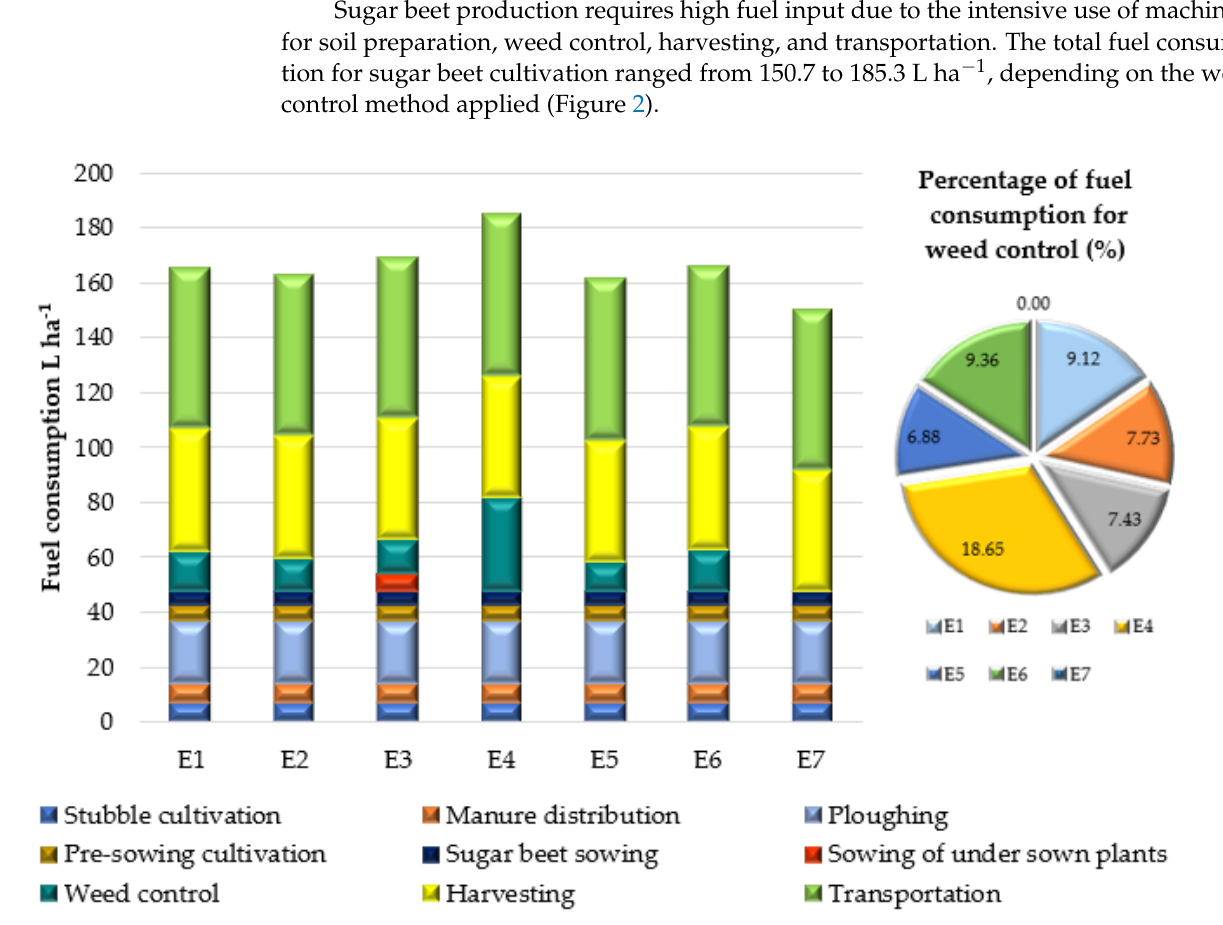
Figure 2. Total fuel consumption of organic sugar beet production using different weed control methods. E1—mechanical weed control (inter-row loosening), E2—mechanical weed control (inter-row cutting and mulching with weeds), E3— smothering weed control (inter-row cutting and mulching with catch crop), E4—thermal weed control (steaming), E5—inter- row loosening (automated), E6—inter-row loosening (robot—diesel powered), and E7—inter-row loosening (robot—electric